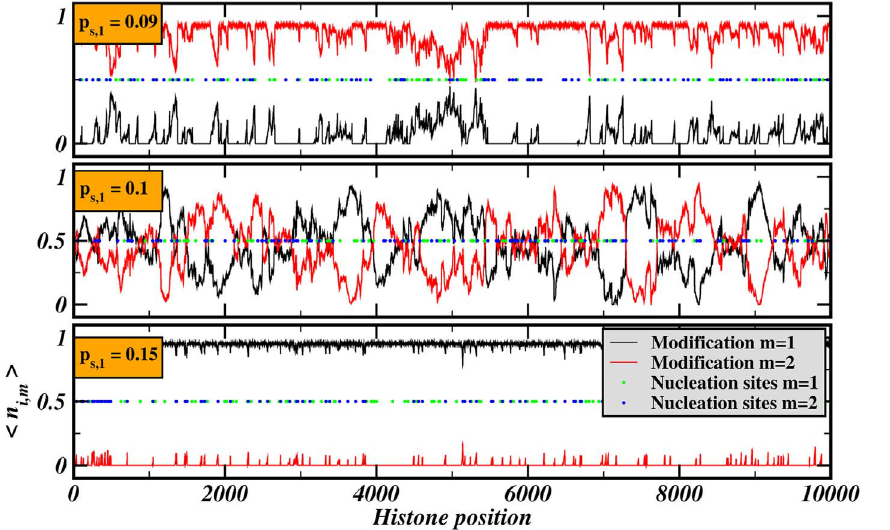
Figure 8. Complete transition of the chromatin landscape for different propagation rates. The figure shows the spatial distribution of modifications averaged over the last iterations, v n i , m w , for different values of p s ,1 . Despite the purely random distribution of nucleation sites, chromatin domains form around accumulations of nucleation sites in the upper two panels. The other parameters were N N ~ 100 , p s ,2 ~ 0 : 1 , p d ~ p a ~ 0 : 01 .